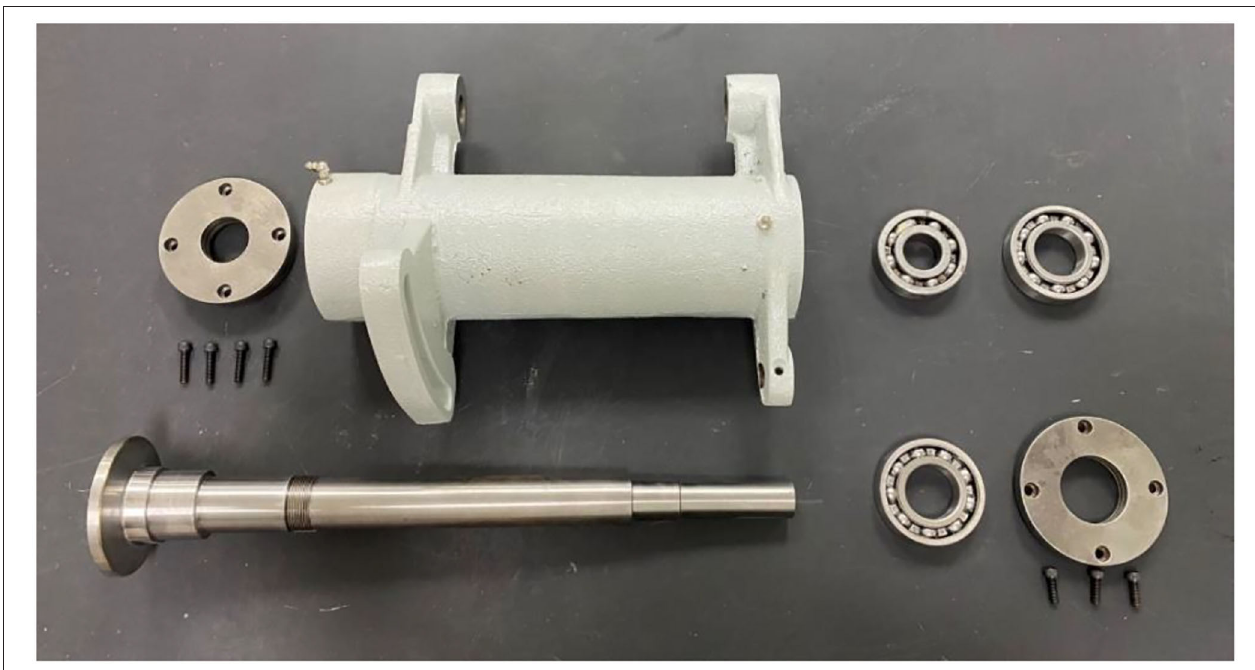
FIGURE 6 | Solid assembly components.